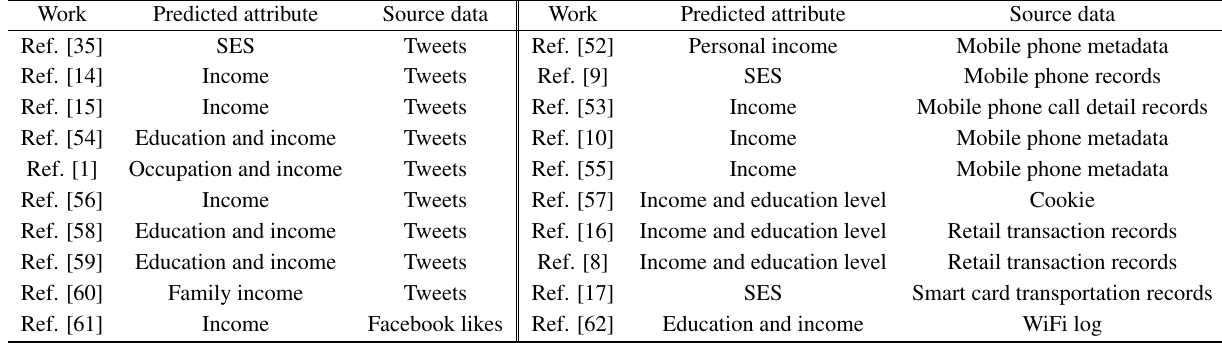
Table 6 Related works of personal income